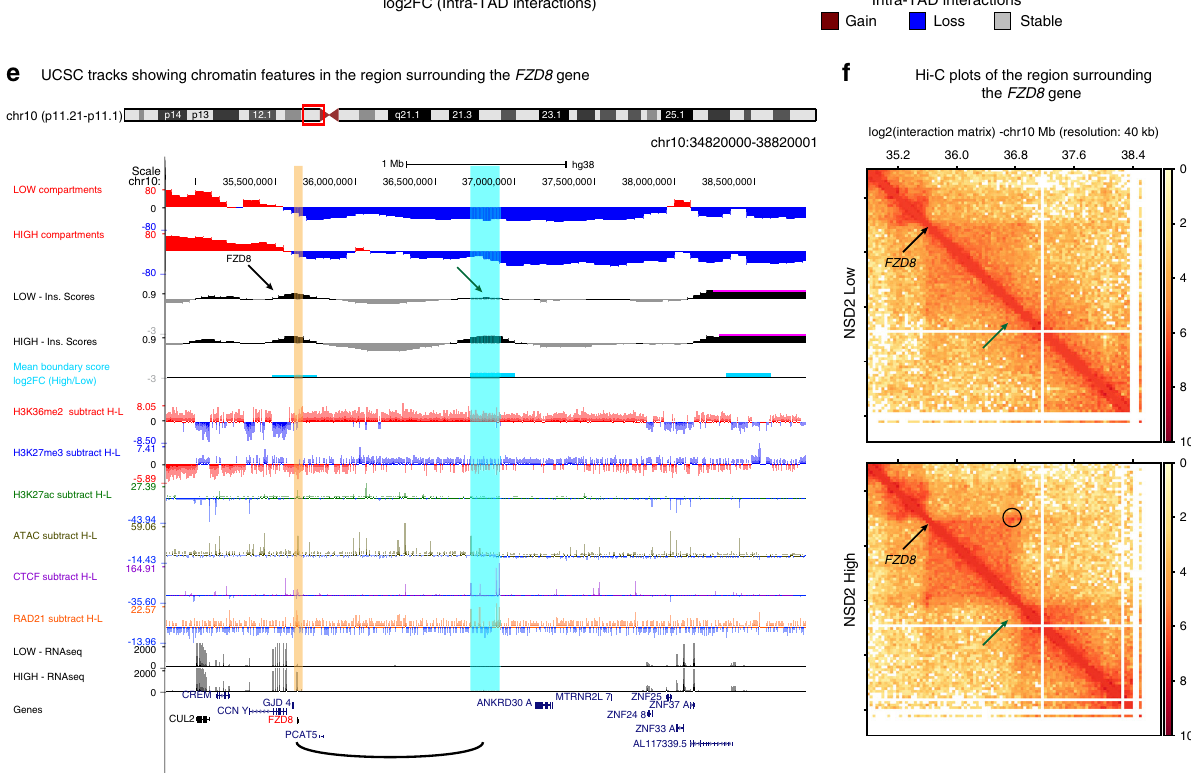
Altered chromatin drives oncogenic transcriptional programs . Within the TADs and loops that harbor signi fi cant changes in CTCF, H3K27ac, and transcriptional output we detected several newly activated oncogenes associated with MM-related pathways. These include the protein tyrosine phosphatase gene, PTPN13 56 , FGF13 57 , and ETV5 58 . The PTPN13 gene, which regulates cell growth 59 , differentiation 56 , mitotic cycle, and oncogenic trans- formation is located within a CTCF-mediated loop which harbors